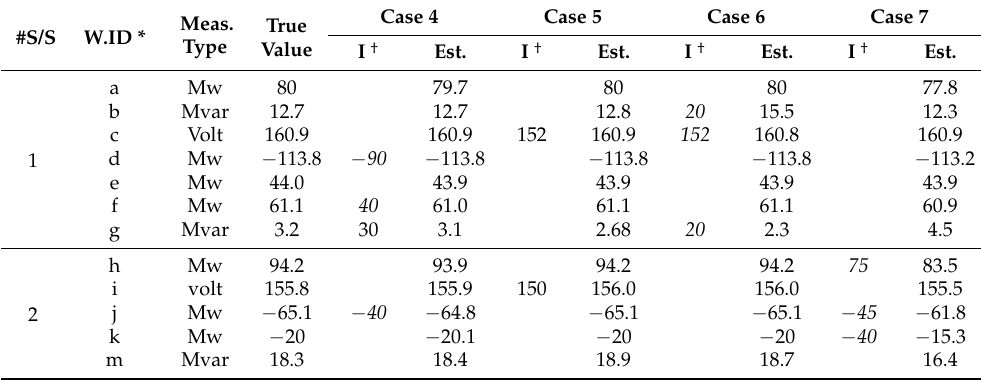
Table 8. Results of the bad data processing for Scenario B.